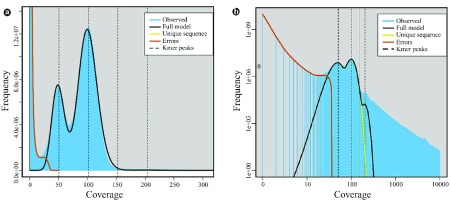
GenomeScope kmer profile plot of the
T. ilisha.Dataset show the fit of the GenomeScope model (black) based on 33-kmers in Illumina HiSeq sequence reads, max kmer coverage at 300× (
a) and 10000× coverage (
b).